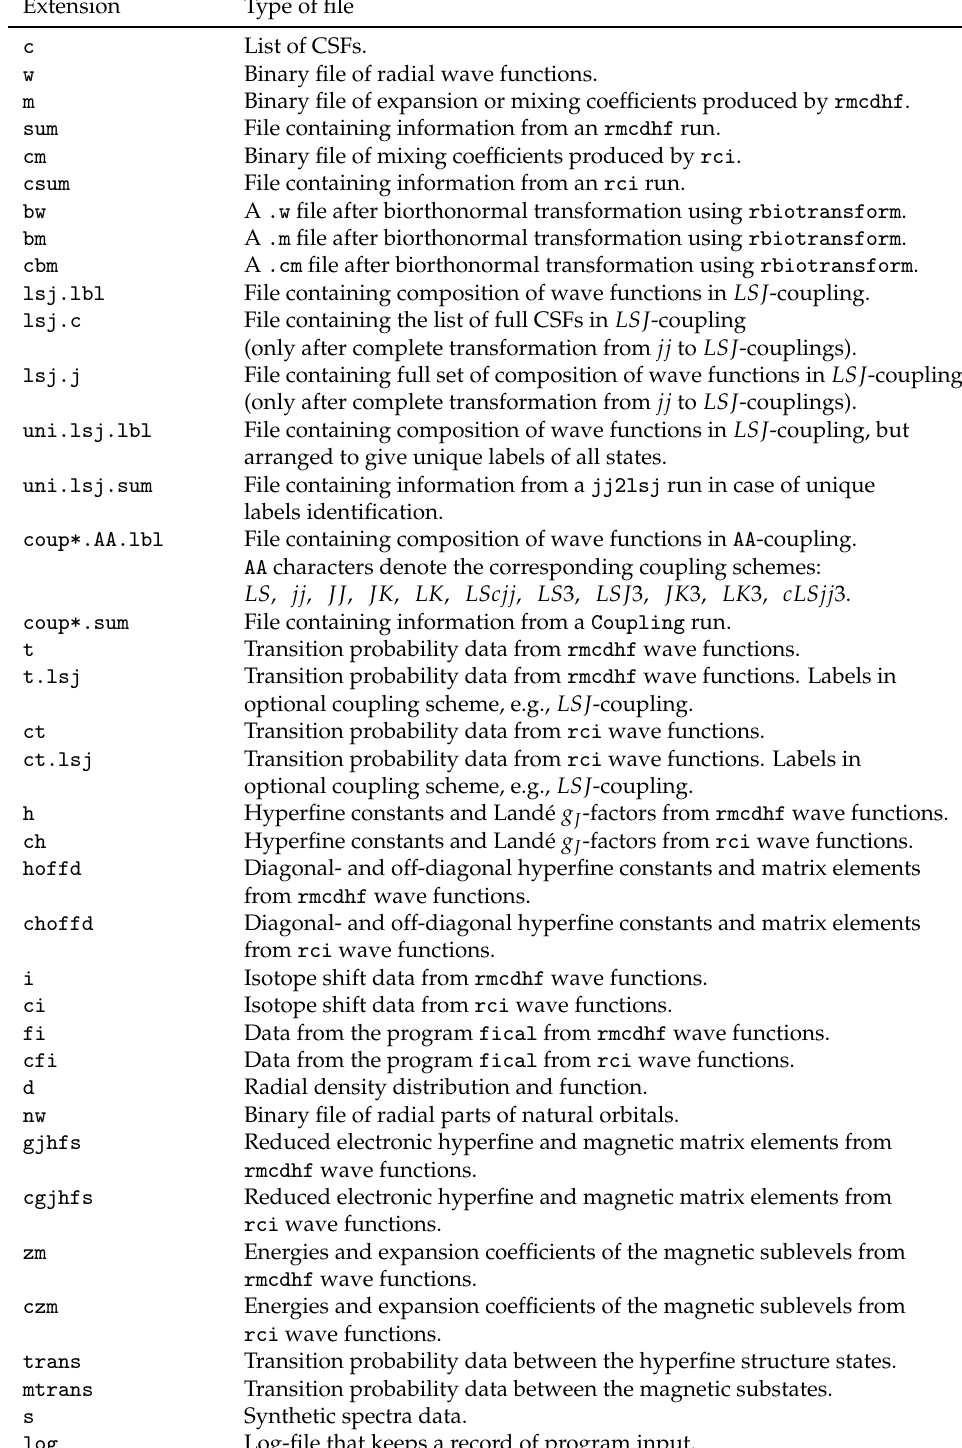
Table 1. Common file